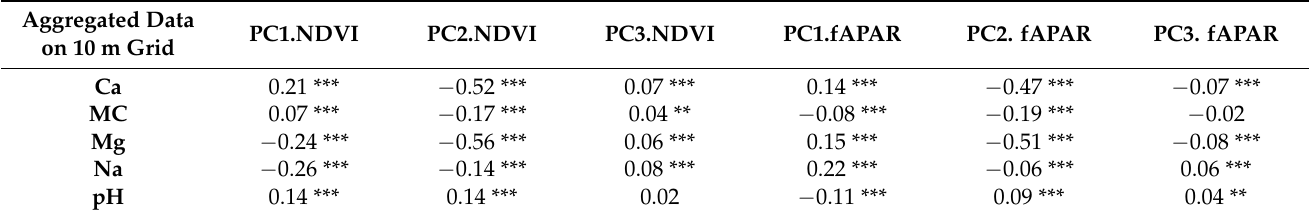
Table 5. Correlation table between aggregated soil variables and PCAs from biophysical